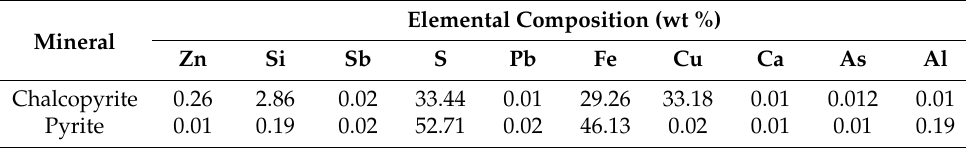
Table 2. Composition of chalcopyrite and pyrite.